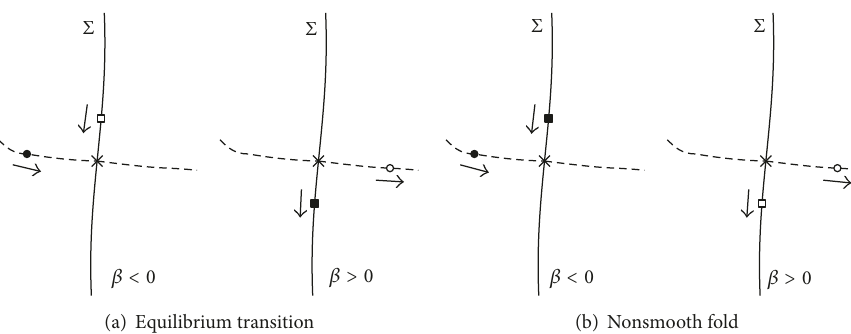
Figure 1: Equilibrium transition and nonsmooth fold bifurcation. The discontinuity boundary Σ is displayed as a solid line. The dashed line represents the motion of the equilibrium as a parameter changes. Round points represent ordinary equilibria (filled) or virtual equilibria (hollow). Square points represent pseudoequilibria (filled) or virtual pseudoequilibria (hollow)